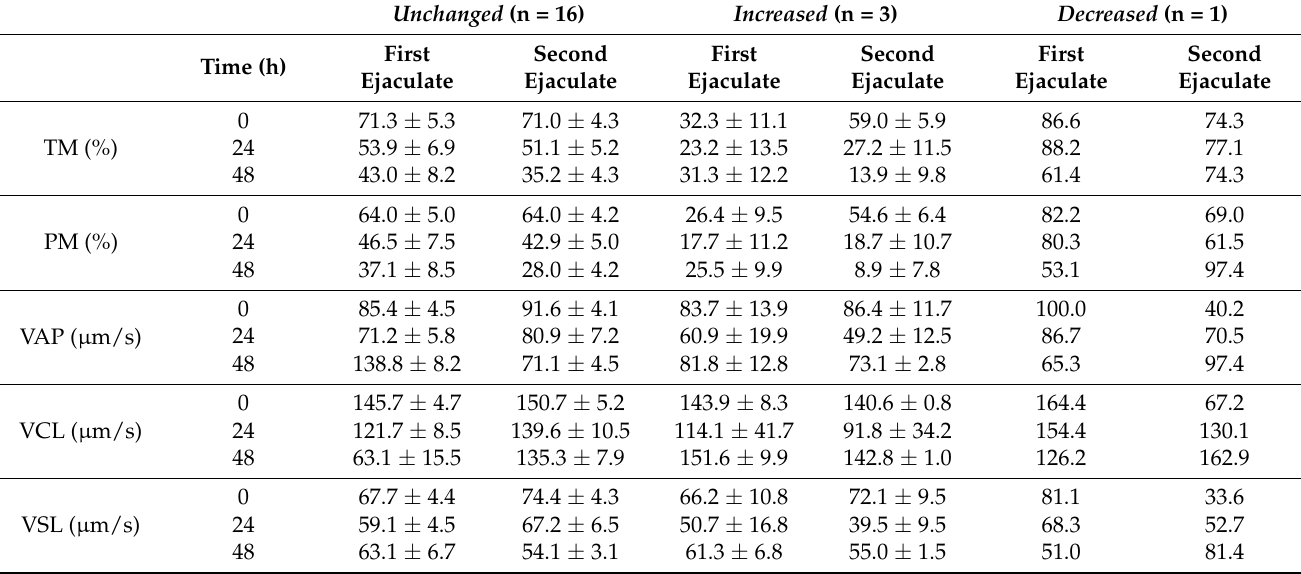
Table 10. Motility parameters of the first and second ejaculates of the season collected from breed- ing inactive stallions (n = 20) after 0, 24, and 48 h of cooling. Based on the motility parameters between the first and second ejaculates, sixteen stallions were classified as unchanged (i.e., ≤ 10% change), three stallions as increased (i.e., improvement > 10%) group, and one stallion as decreased (i.e., reduction >